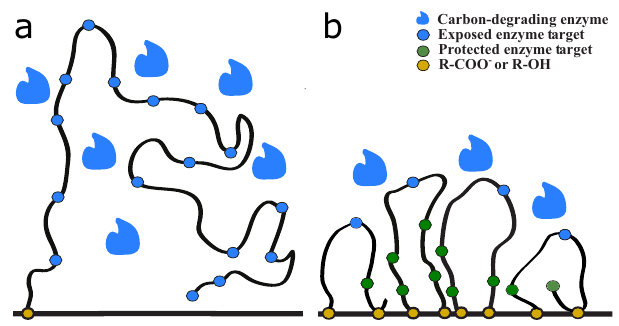
Fig. 1 Comparison of biopolymers and their interaction with mineral surfaces before and after partial degradation by oxidative metabolisms. Panel ( a ) illustrates a generic scenario in which only one site of the biopolymer is sorbed to the mineral surface (horizontal line) and the exposed enzyme targets on the biopolymer are freely accessible to carbon- degrading enzymes secreted by microorganisms. Panel ( b ) shows the result of further degradation of the biopolymer in ( a ) after partial oxidation. Reactive oxygen-containing functional groups, such as carboxyls (R-COO − ) and hydroxyls (R-OH) are formed by oxidative enzymes (e.g.,